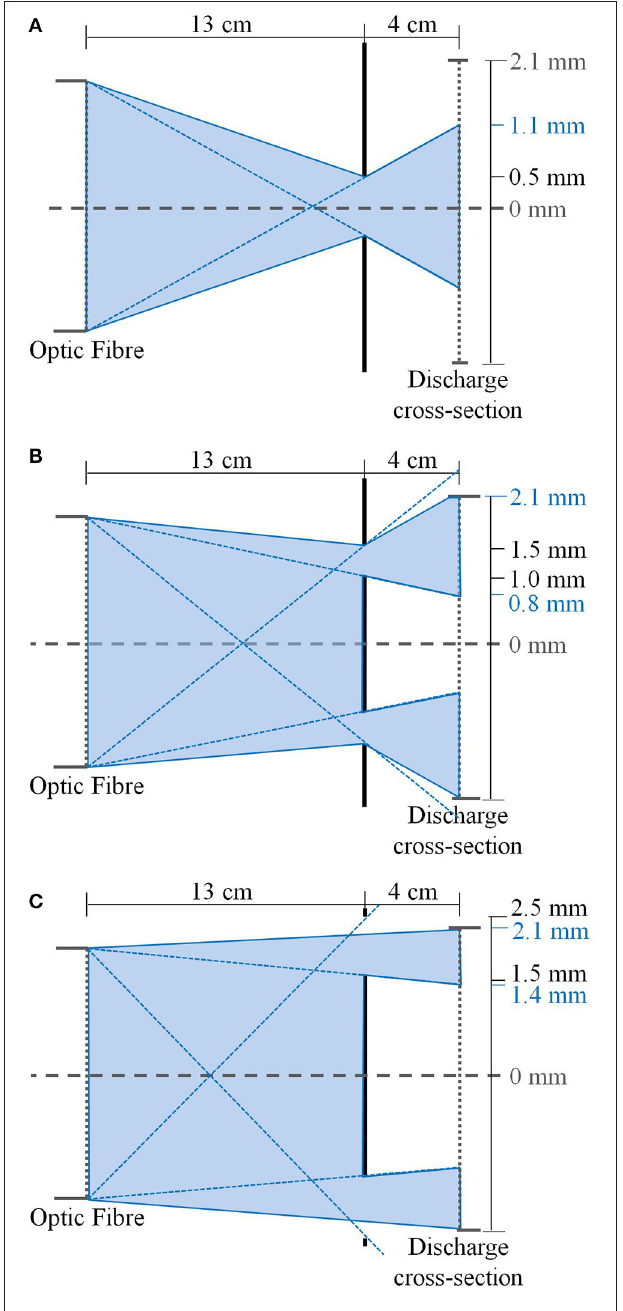
FIGURE 3 | Optical ray diagrams showing spatial regions of interest for (A) 0–0.5 mm radius circular mask giving a region of interest r 1 = 0 − 1.1 mm, (B) 1–1.5 mm radius annular mask giving a region of interest